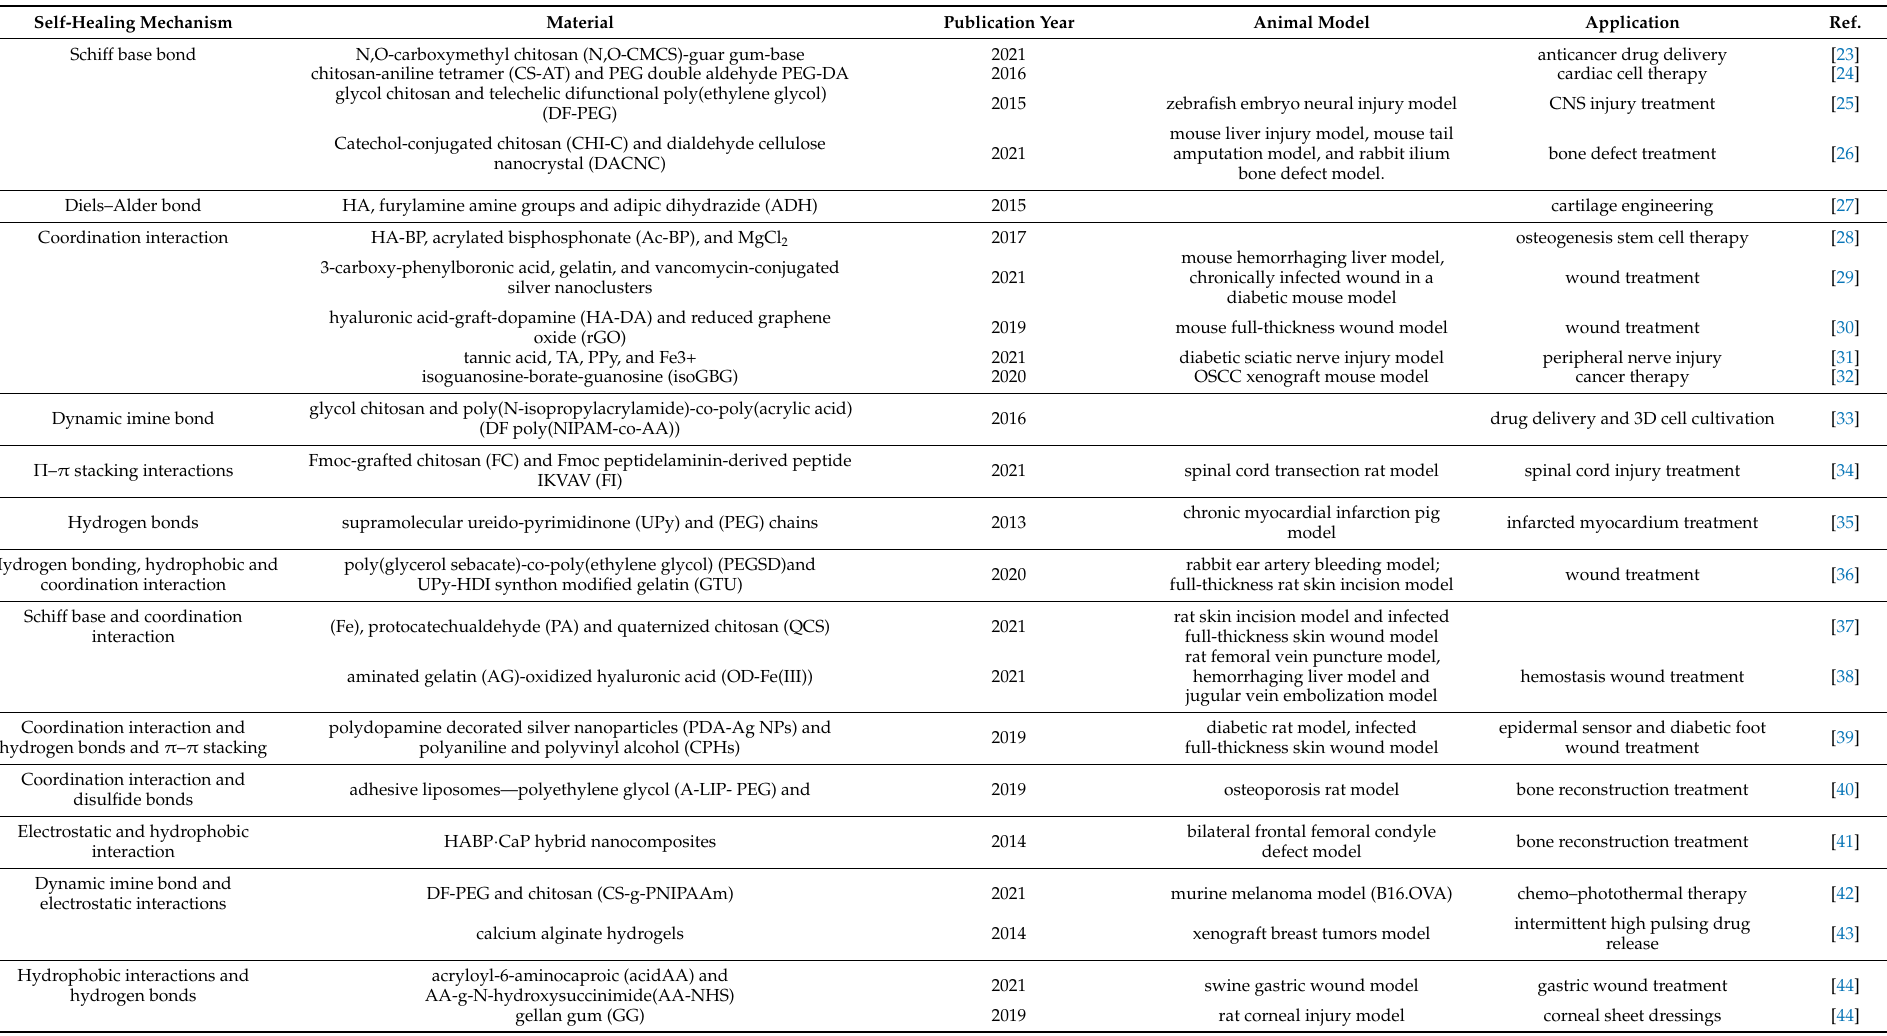
Table 1. Clinical applications of self-healing hydrogels: a brief summary of recent